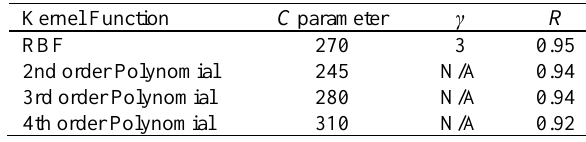
Table 5. Optimal training settings for SVM kernel